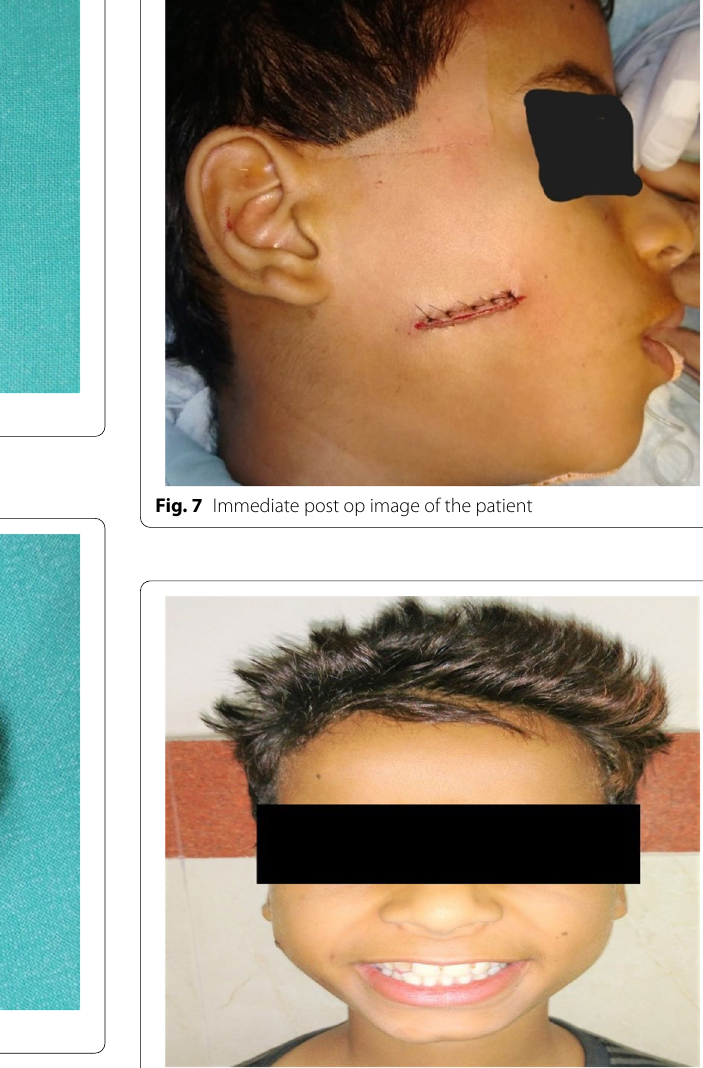
Fig. 8 Image of the patient after 1